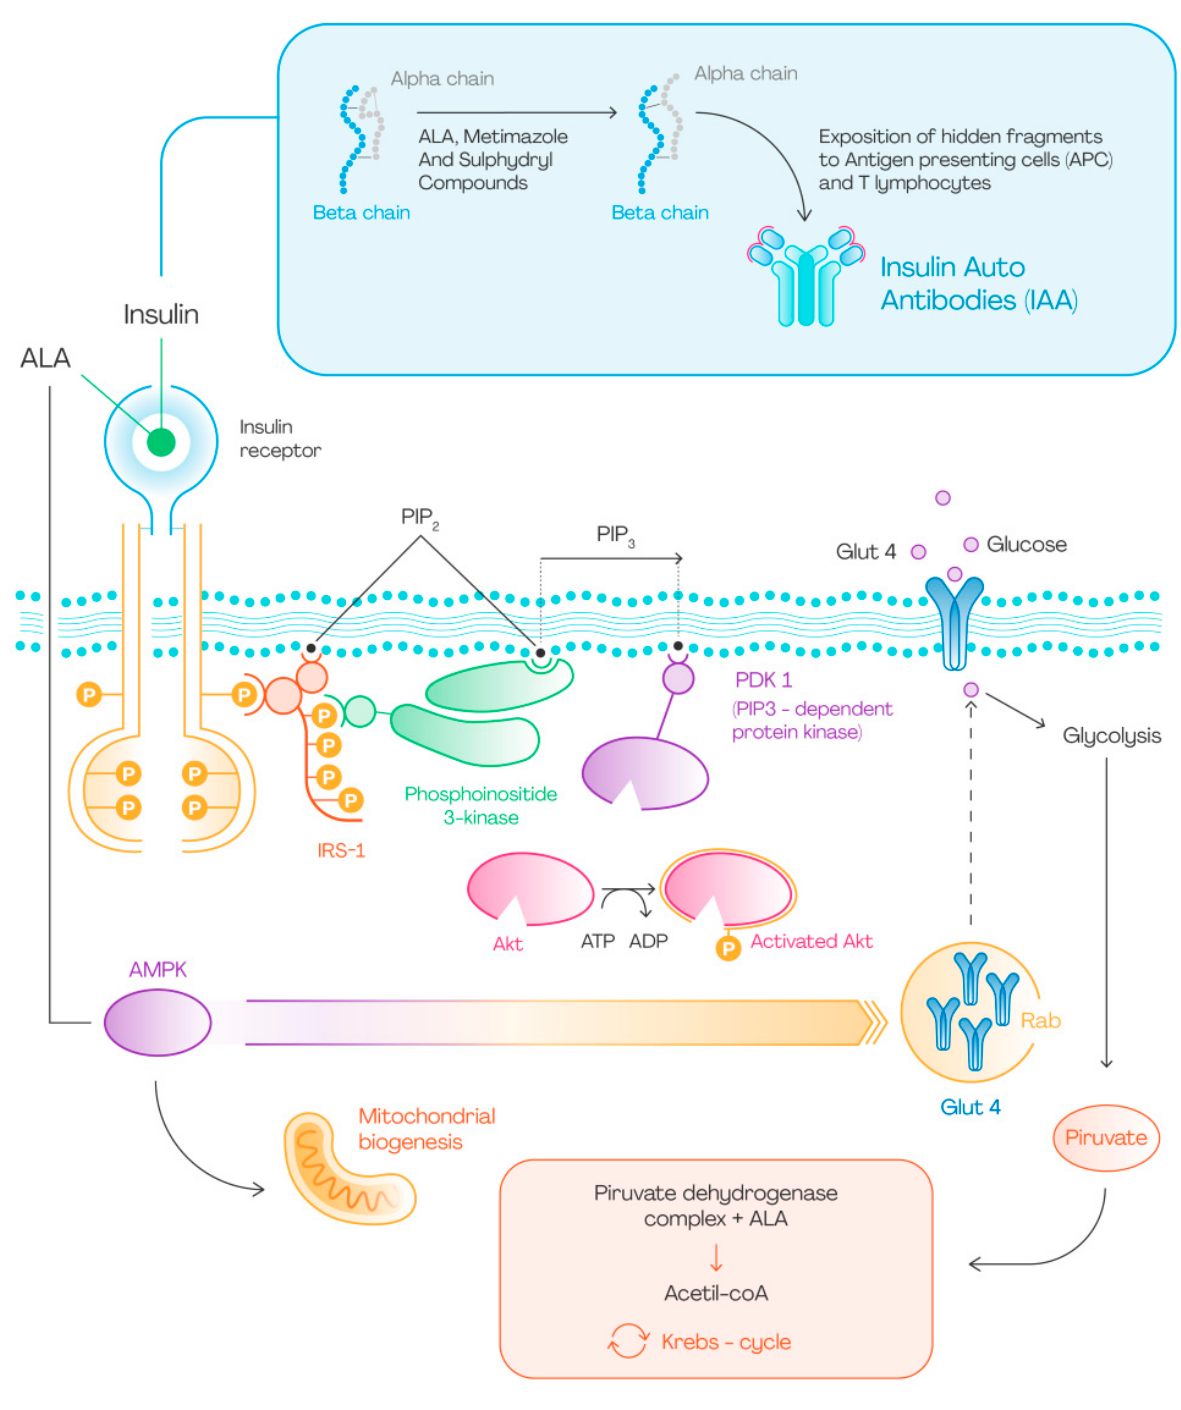
Figure 1. ALA and glucose metabolism.